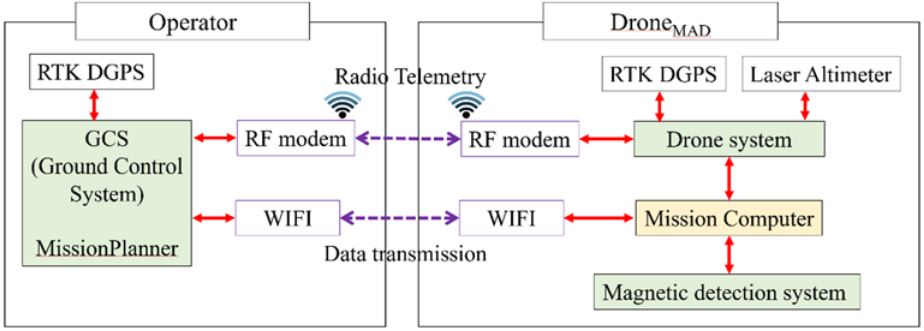
Figure 4. Schematic diagram of the navigation system and magnetic data flow.